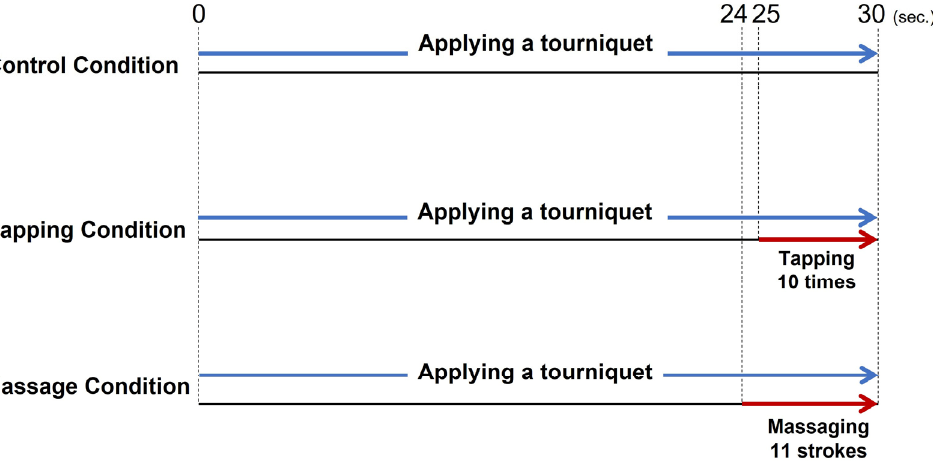
Figure 1. Protocol of venous dilation procedures. Notes: Control condition, the tourniquet application; Tapping condition, the tourniquet application and to be tapped on the forearm; Massage condition, the tourniquet application and to be massaged on the forearm. All three venous dilation procedures were performed for all participants.